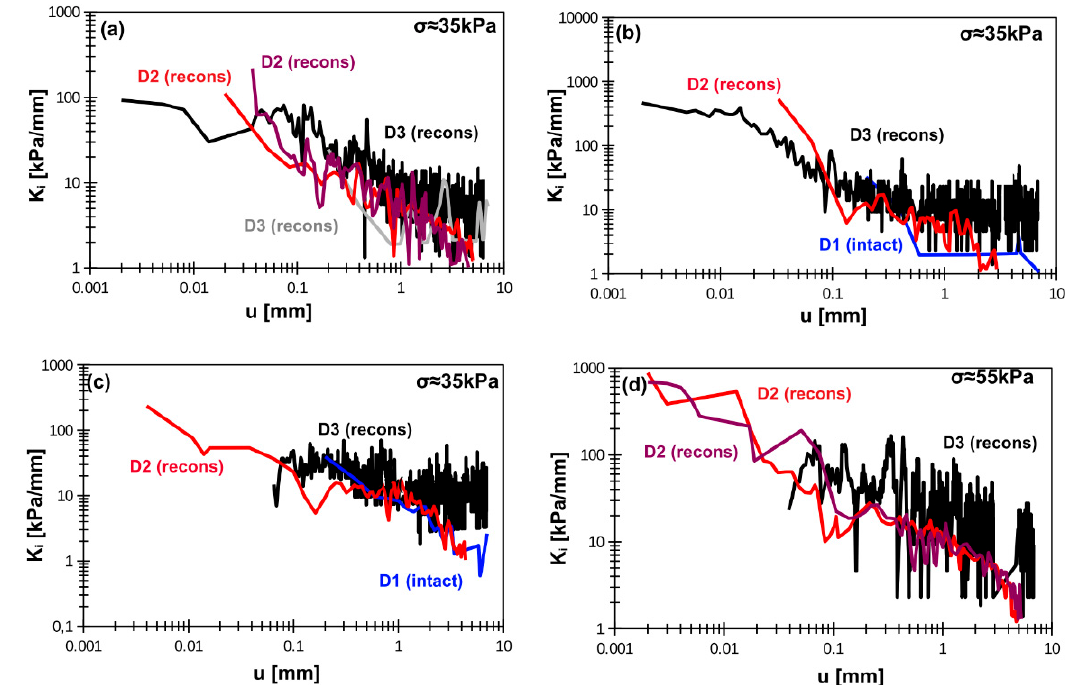
Figure 8. Rough concrete–soil interface stiffness degradation for ( a ) silty loam, ( b ) organic clay, ( c ) peat, ( d ) organic silt. Note: D1, D2, D3 indicate device type; intact = intact sample, recons = reconstituted sample.